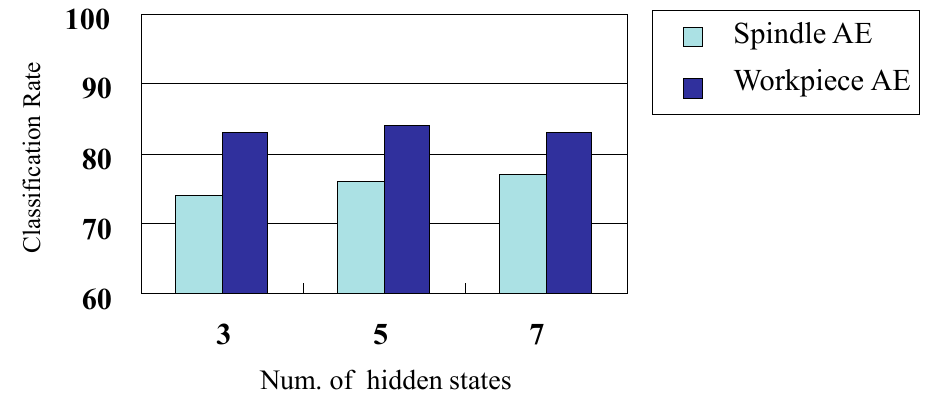
Figure 16. Effect of hidden state on the classification rate of tool wear condition (64 KHz feature bandwidth).